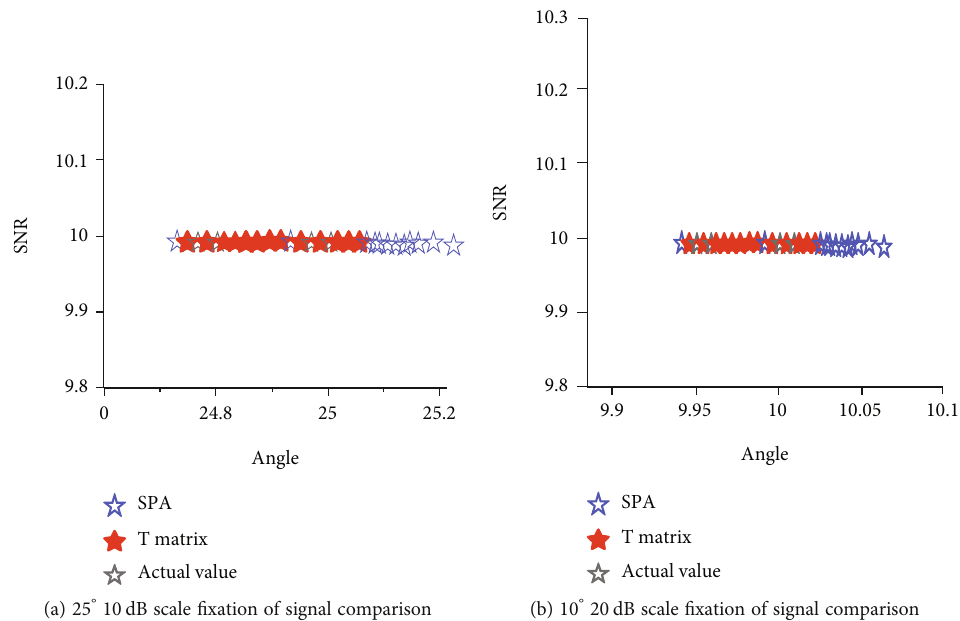
Figure 10: Enlarged view of DOA accuracy of T-matrix reconstruction algorithm and SPA